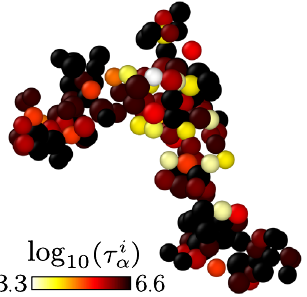
FIG. 15. Dynamic facilitation in the 3D model. A connected cluster containing 163 mobile particles at T ¼ 0 . 07 inside a 3D system composed of N ¼ 10 4 particles (linear size L ¼ 21 . 5 ) at time t ¼ 4 . 1 × 10 6 . The particles are represented at their position at t ¼ 0 using a color which codes for τ i α